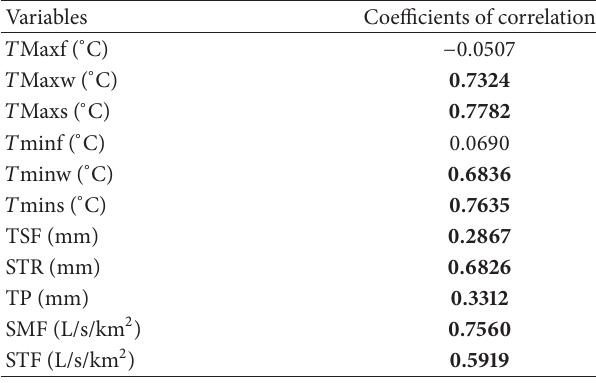
Table 3: Correlation coefficients calculated between hydroclimate variables measured in the two